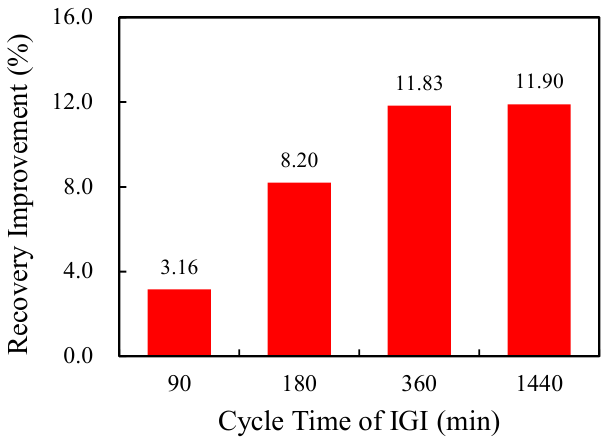
Figure 4. Oil recovery improvement for different cycle times.